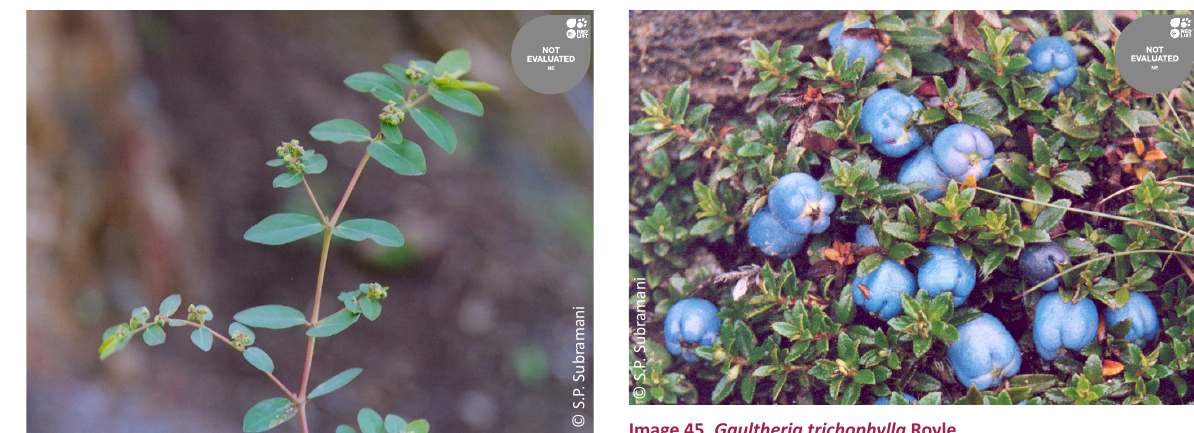
Image 44. Euphorbia parviflora L.